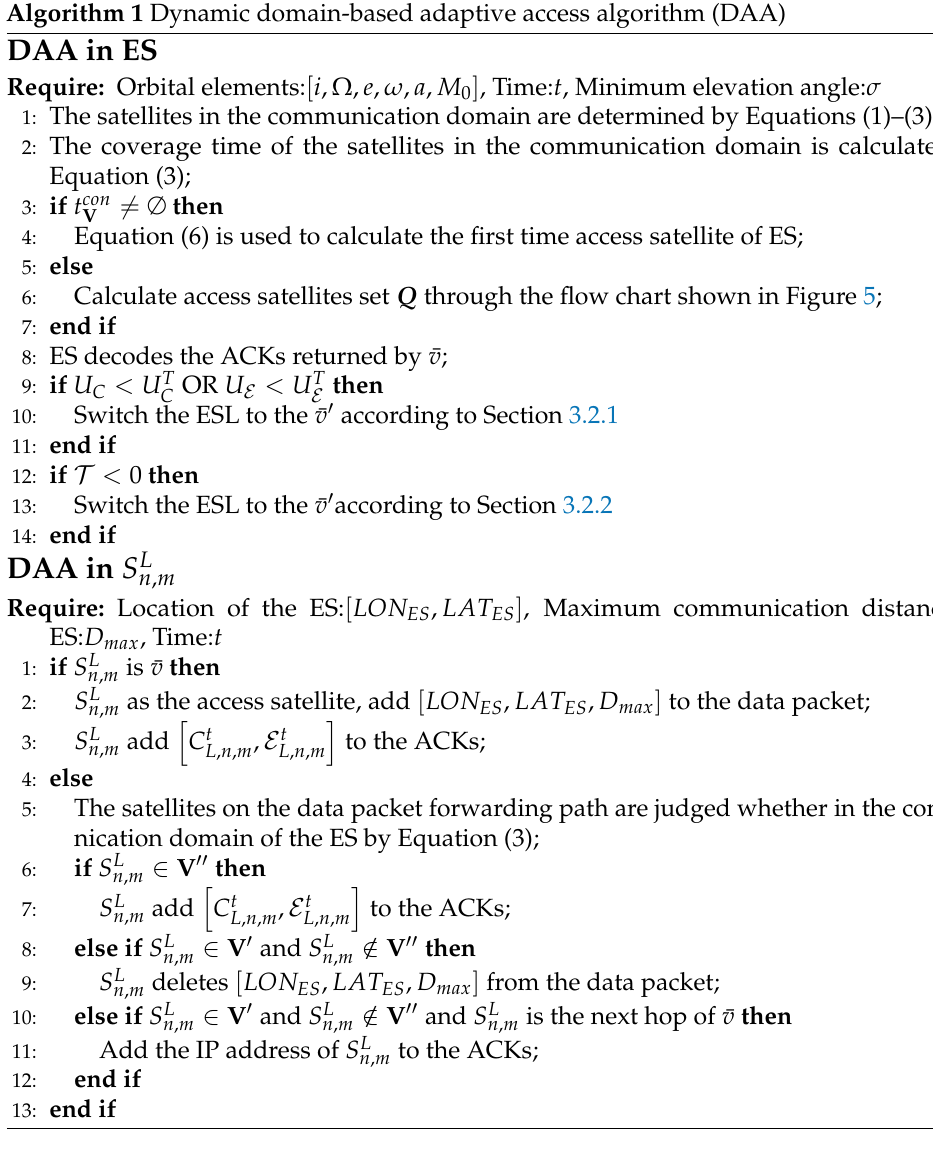
Algorithm 1 Dynamic domain-based adaptive access algorithm